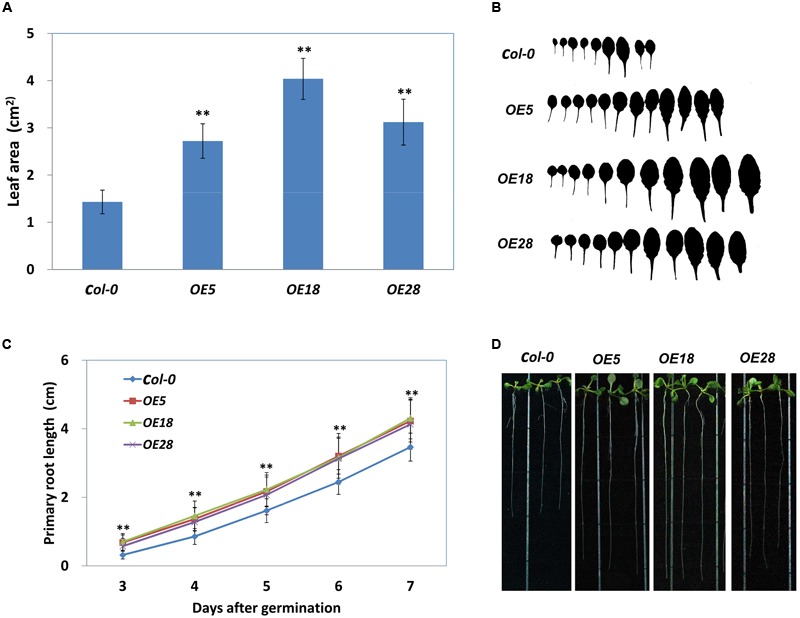
Enlarged organ size in Arabidopsis plants that overexpress HbEBP1. (A) Leaf area of the first adult-stage leaf (the seventh leaf) in the Col-0, OE5, OE18 and OE28 lines. Leaves from at least 20 individual seedlings were measured for each line. (B) The morphology of rosette leaves from the Col-0, OE5, OE18 and OE28 seedlings arranged from left to right in the order of initiation. (C) Primary root elongation was faster in the OE5, OE18 and OE28 lines. The seedlings were cultured vertically, and the root length was measured daily. Roots from at least 20 individual seedlings were measured for each line. (D) Representative seedlings show the primary root length at 8 days after germination. Data in (A,C) were presented as mean ± standard error of mean of at least 20 individual seedlings. Student’s t-test was carried out for statistical analysis. Significant difference was defined by ∗∗p < 0.01.